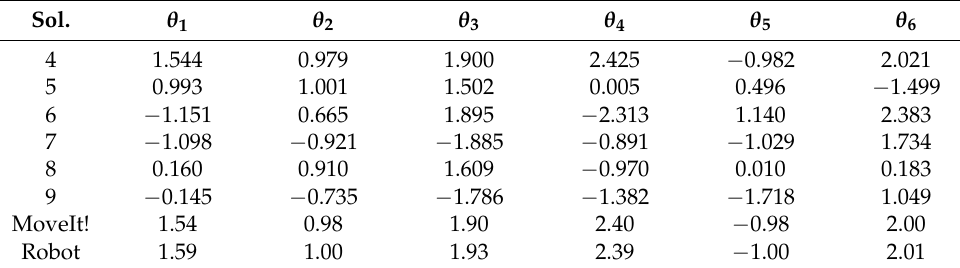
Table 5. Feasible solutions to example no. 1 (in